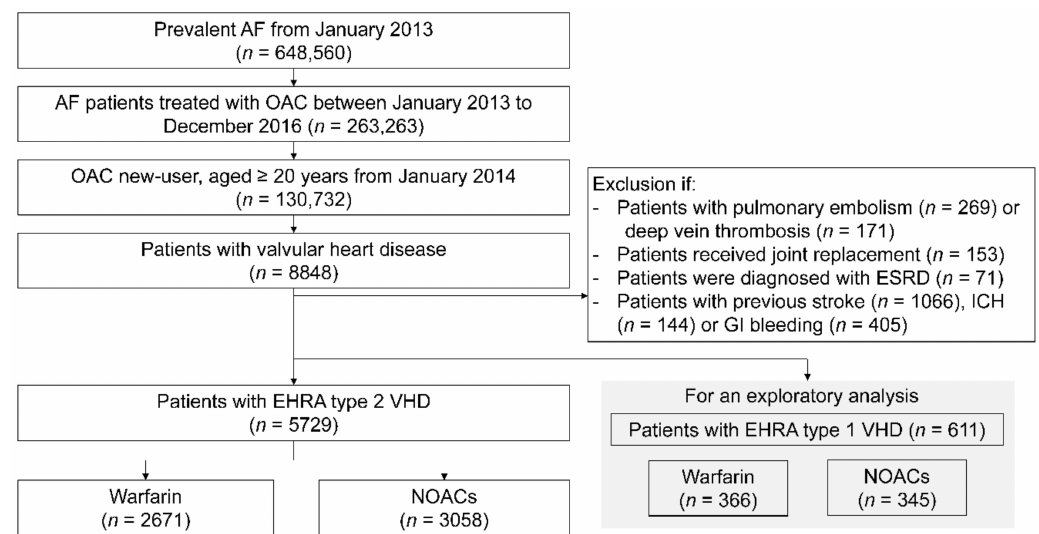
Figure 1. Study population enrollment flow. A total of 5729 patients with EHRA type 2 VHDs were included in the final analysis. We conducted an exploratory analysis for EHRA type 1 VHD patients (patients with “valvular AF”) ( n = 611). Abbreviations: AF, atrial fibrillation; EHRA, Evaluated Heartvalves, Rheumatic or Artificial; ESRD, end-stage renal disease; GI, gastrointestinal; NOAC, non-vitamin K antagonist oral anticoagulant; OAC, oral anticoagulant, VHD, valvular heart